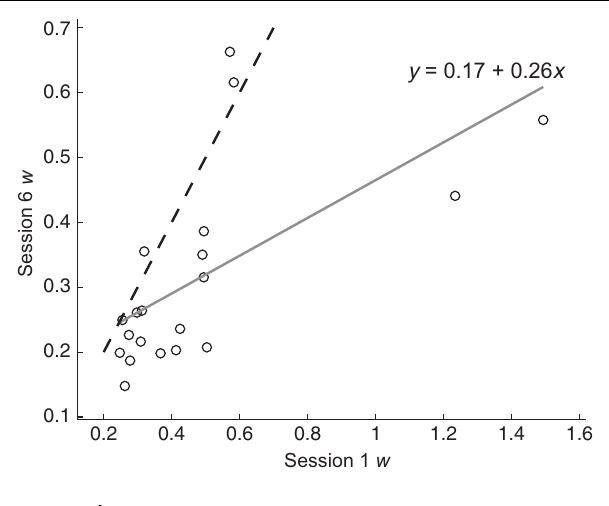
FIGURE 3 | Numerosity w scores calculated from session 6 plotted against numerosity w scores calculated from session 1. The dashed line shows equality. Participants below the equality line showed improvement in ANS acuity between sessions 1 and 6.The solid gray line is the best fit to the data and the equation shows the intercept and slope ( r 2 = 0.40, p < 0.005).